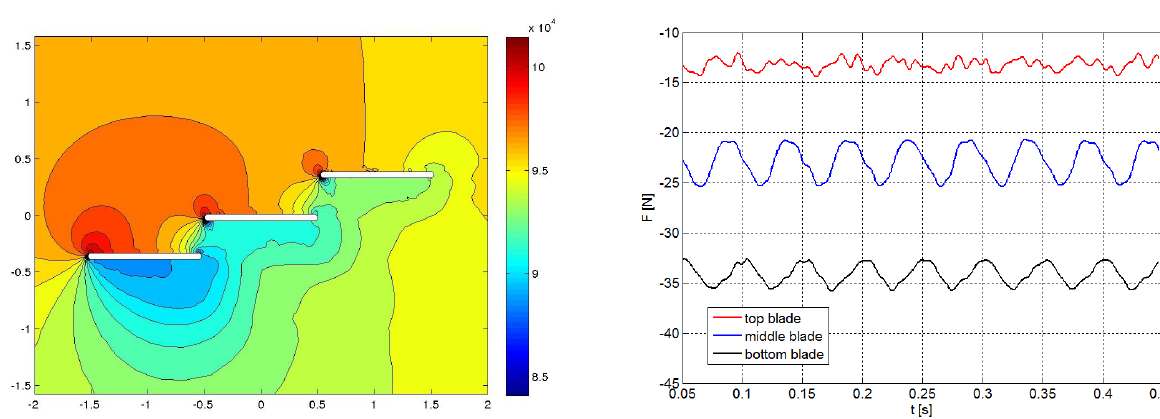
Fig. 7. Time development of y-components of aerodynamic forces acting on the upper (red), middle (blue) and bottom (black) plates.